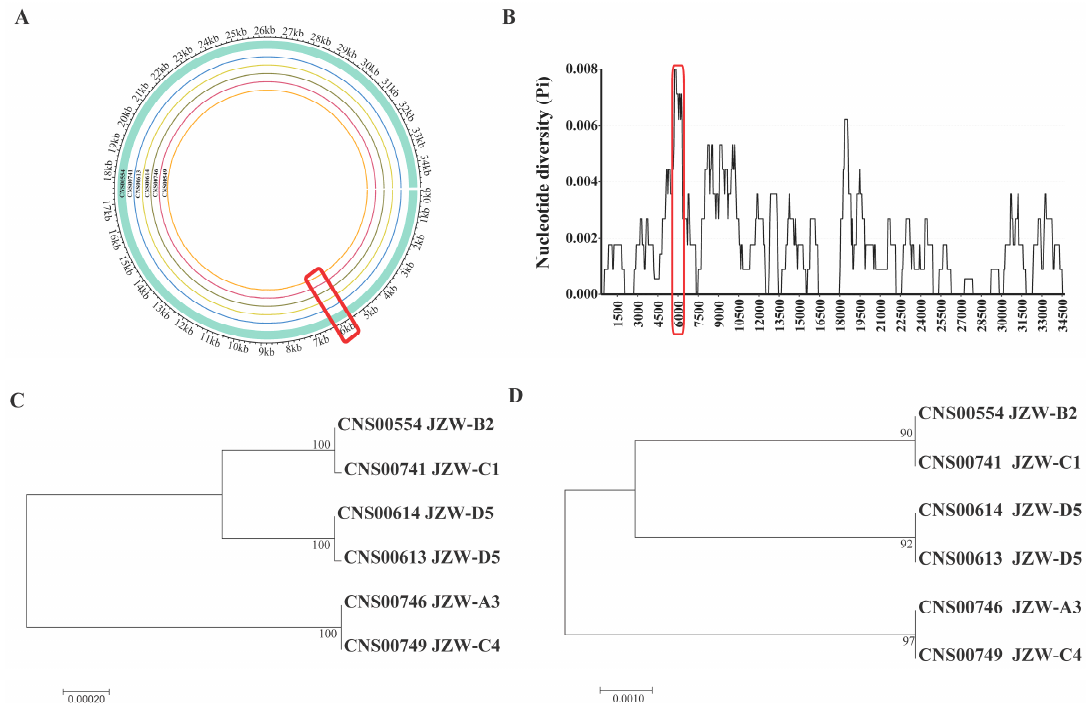
Figure 7. Genomic variations and phylogenetic trees based on maximum likelihood (ML) analysis of six C. granii strains. ( A ): Genomic variations density in six C. granii strains. The cyan band represented the reference genome CNS00554. The range of cgmt1 region was marked by red box. From inside to outside, circles represent six C. granii strains isolated from the Jiaozhou Bay. ( B ): Sliding window analysis of nucleotide variability (Pi) across complete mtDNAs of six C. granii strains. ( C ): Phylogenetic analysis using the whole mtDNAs of six C. granii strains. ( D ): Phylogenetic analysis using the newly developed marker cgmt1 . The sea area label marked with abbreviations: Jiaozhou Bay (JZW).